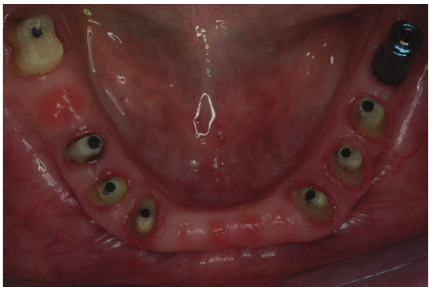
Figure 32: At this point, the patient could be considered stable from a perioprosthetic point of view, waiting 6 more months for a final reevaluation.